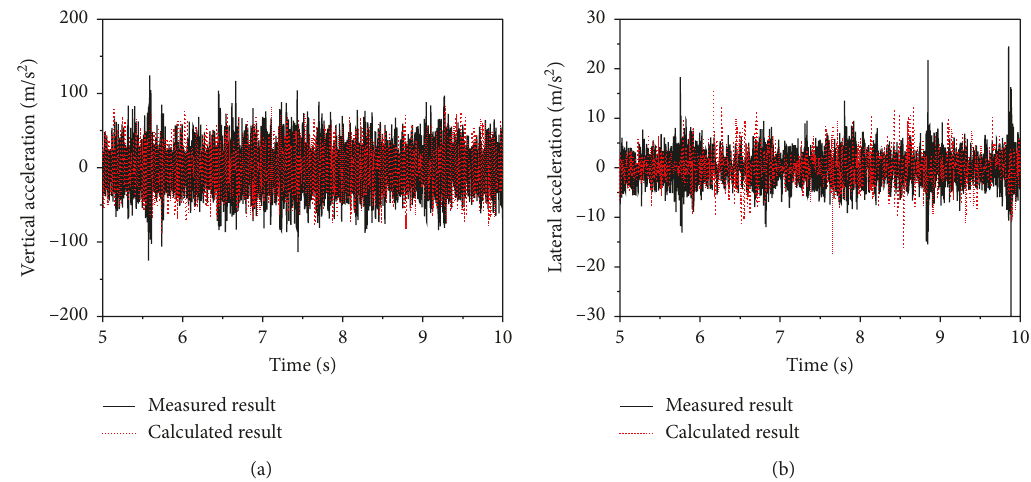
Figure 7: Comparison of measured and calculated result of axle box acceleration at a speed of 350km/h: (a) time history of vertical acceleration; (b) lateral acceleration.